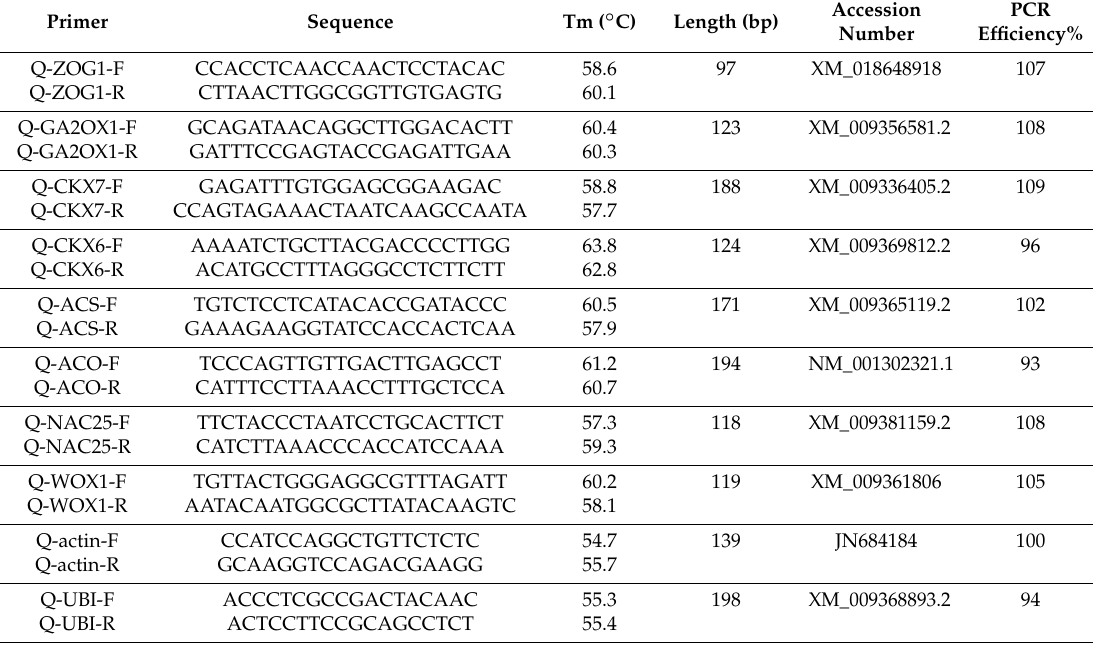
Table 2. The primers of Q-PCR in present